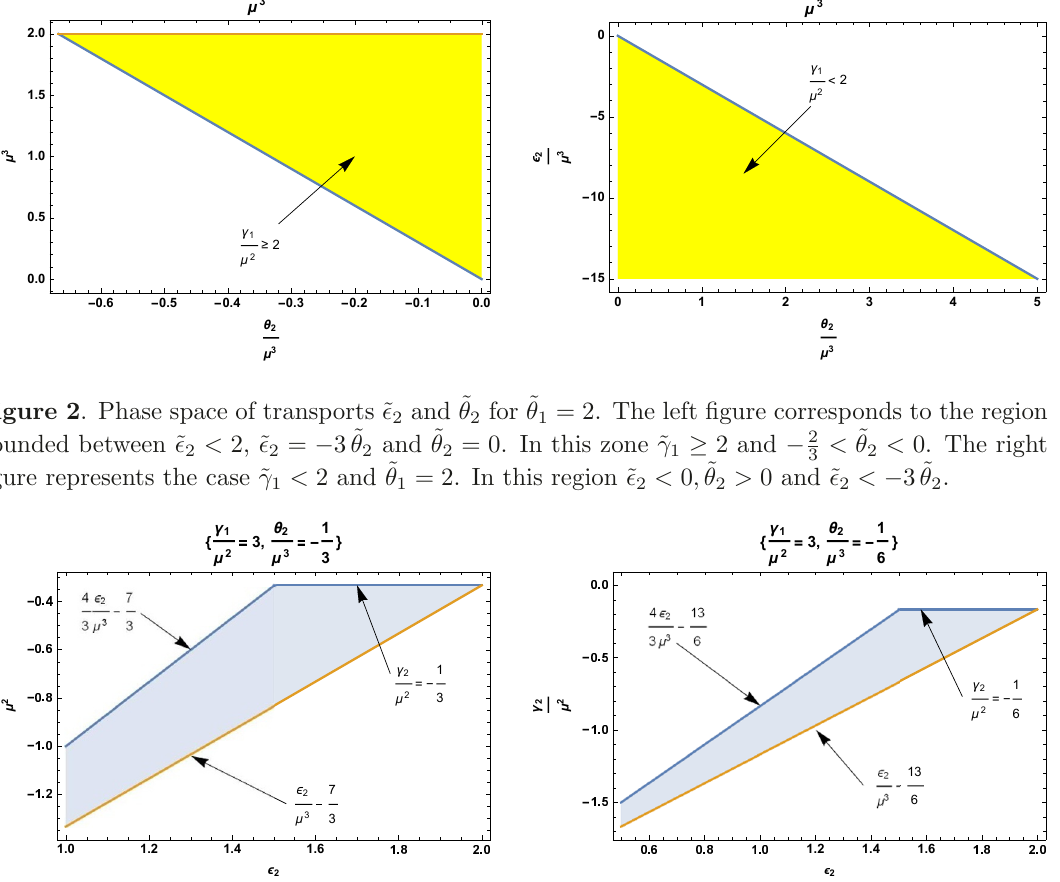
0 which is compatible ≤